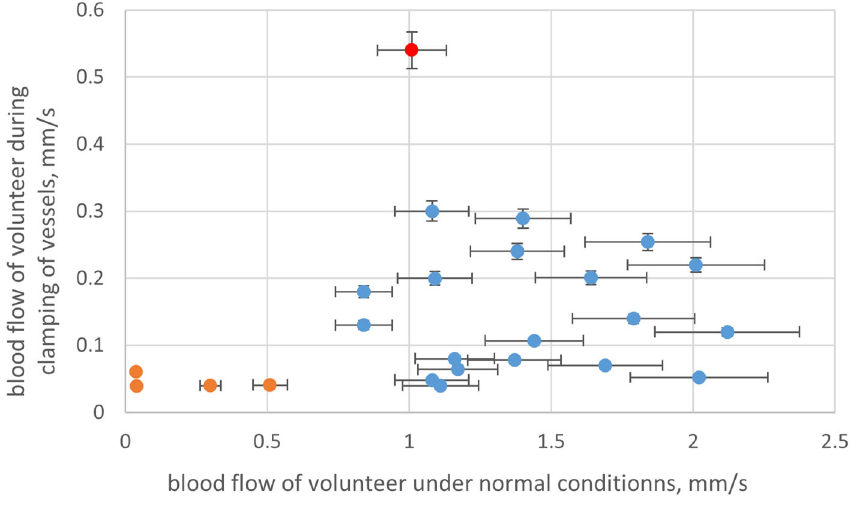
Figure 11. Obtain results for study of blood flow velocity. Blue dots—healthy volunteers, orange dots—volunteers with cardiovascular diseases, red dot—healthy volunteer with abnormally high blood speed (clamped vessel).